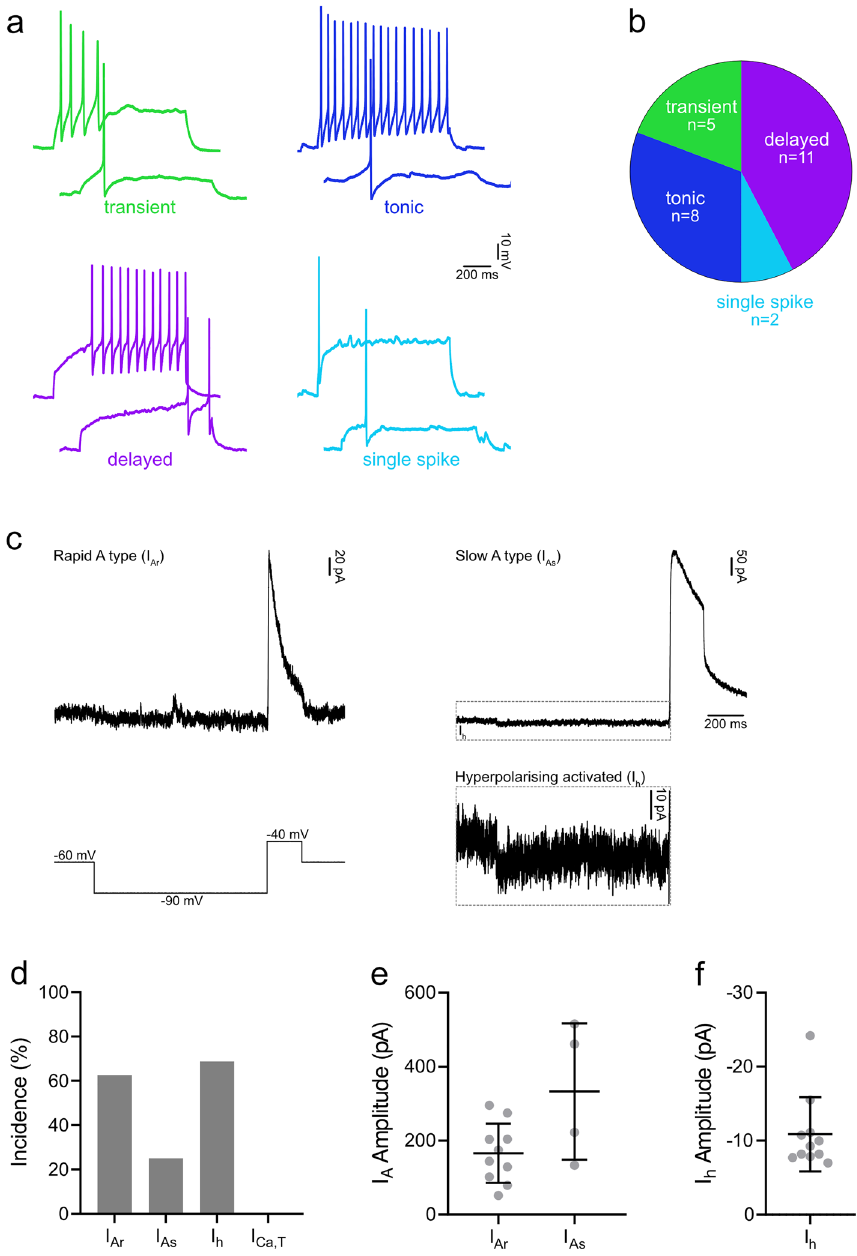
Figure 9. Action potential firing patterns and subthreshold voltage-activated currents in NPFF cells. ( a ) Examples of action potential firing patterns observed in NPFF cells in response to 1 s suprathreshold current injections. ( b ) The most prominent type of firing pattern seen in NPFF cells was delayed firing (11/26; 42.3%), with smaller proportions exhibiting tonic (8/26; 30.8%), transient (5/26: 19.2%) or single spike firing (2/26: 7.7%). ( c ) Representative traces demonstrating the subthreshold voltage-activated currents in NPFF cells that were revealed using a voltage step protocol that hyperpolarised cells from -60 to -90 mV for 1 s and then depolarised cells to -40 mV for 200 ms (bottom left trace). The currents that are revealed by this protocol were classified as rapid (I Ar ) or slow (I As ) A-type potassium currents, or hyperpolarising-activated currents (I h ). The example traces of I Ar (top left) and I As with I h (top right) show an average of 5 traces. The example of I h (dashed outline) is shown at a different y-axis scale (bottom right). ( d ) Almost all NPFF cells displayed I A , which was mostly classified as I Ar (10/16; 62.5%), but with some exhibiting I As (4/16; 25.0%). Many cells exhibited I h (11/16; 68.8%), which was typically seen in addition to I Ar (5/16; 31.3%) or I As (4/16; 25.0%). The peak amplitude of I A was 165.7 ± 80.3 and 333.0 ± 184.1 pA for I Ar and I As , respectively ( e ) and the amplitude of I h , measured during the final 200 ms of the hyperpolarising step, was -10.9 ± 5.0 pA ( f